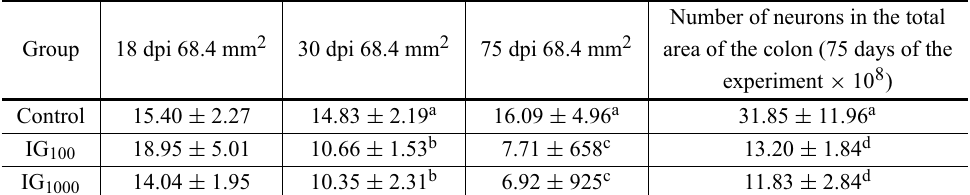
Mean and standard deviation of the myenteric neuronal density* in the colon of Swiss male mice infected by the strain Y with 100 (IG 100 ) and 1000 (IG 1000 ) forms of trypomastigotes and the non-infected controls.